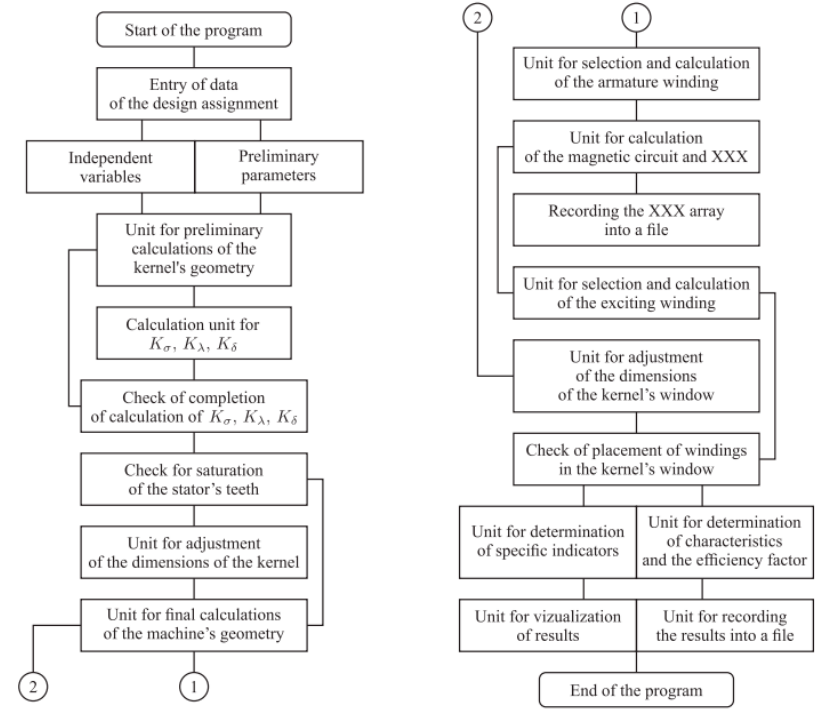
Figure 5. A flowchart of the calculation process.